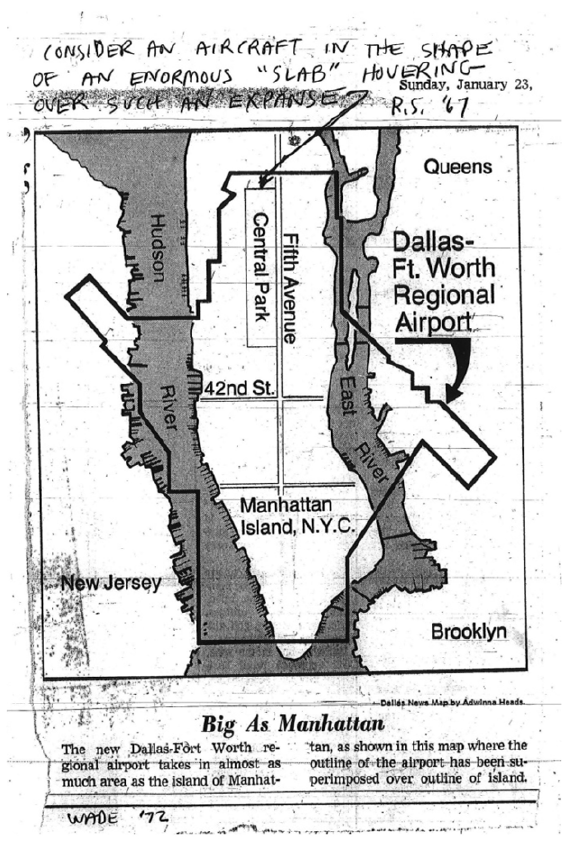
Figure 6. Robert Wade sent this clipping from the January 23th 1971 edition of Dallas Paper to Robert Smithson